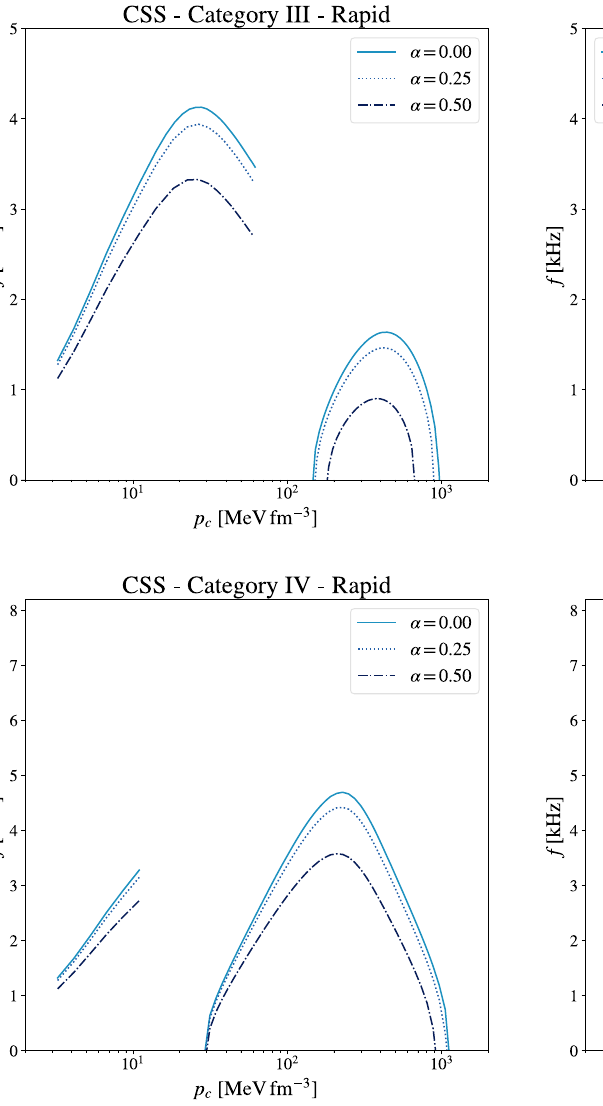
panels) and IV (lower panels) of the CSS parametrization. Note that the frequencies are not in the same scale for the different